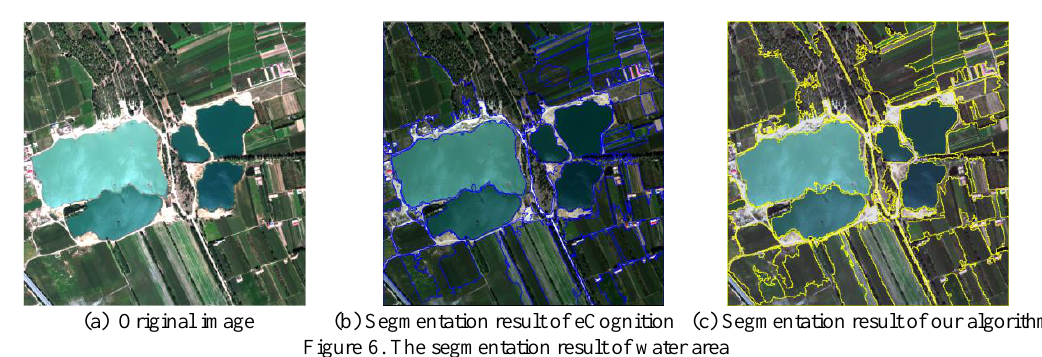
Figure 3. The segmentation result of vegetation